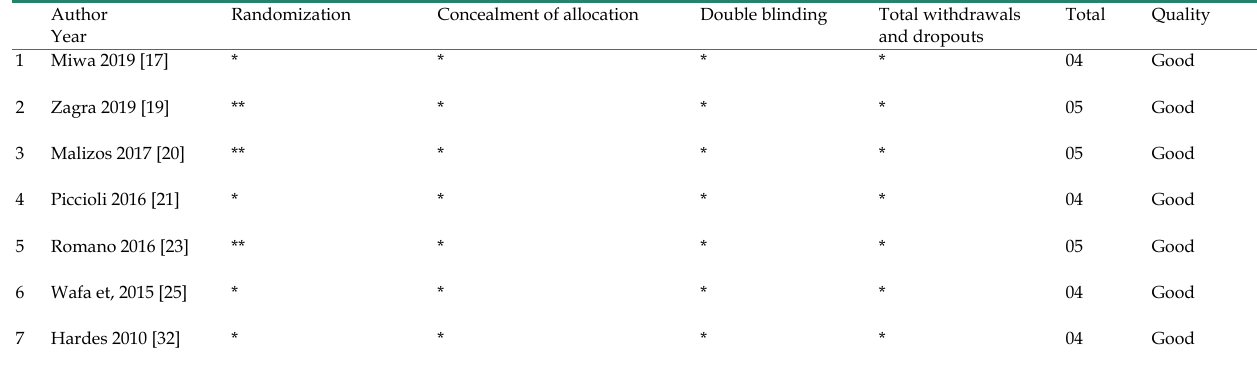
Table 2b. Study quality of the studies fulfilling the meta-analysis evaluation criteria based on the modified Jadad scale. Author Year